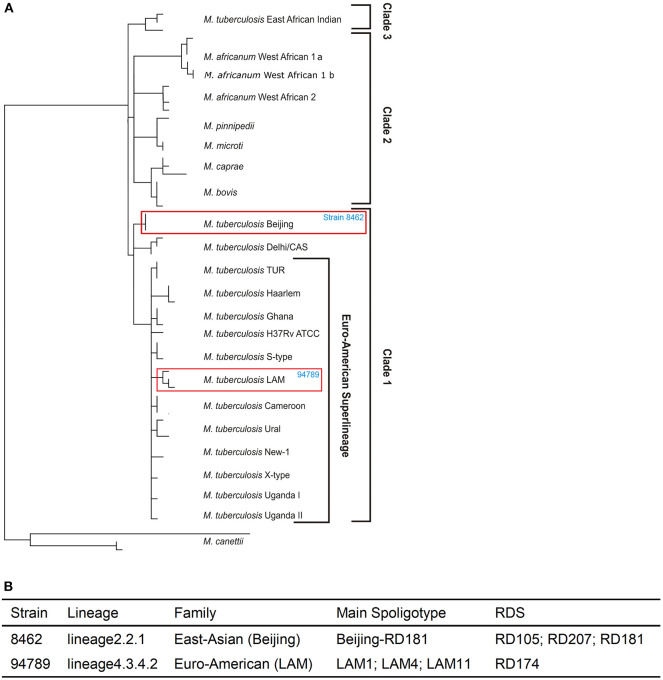
The two MDR strains are from different lineages. (A) The positions of strain 8462 and strain 94789 in the phylogenetic tree. (B) The detailed lineages of strain 8462 and strain 94789. Analysis using TB Profiler.